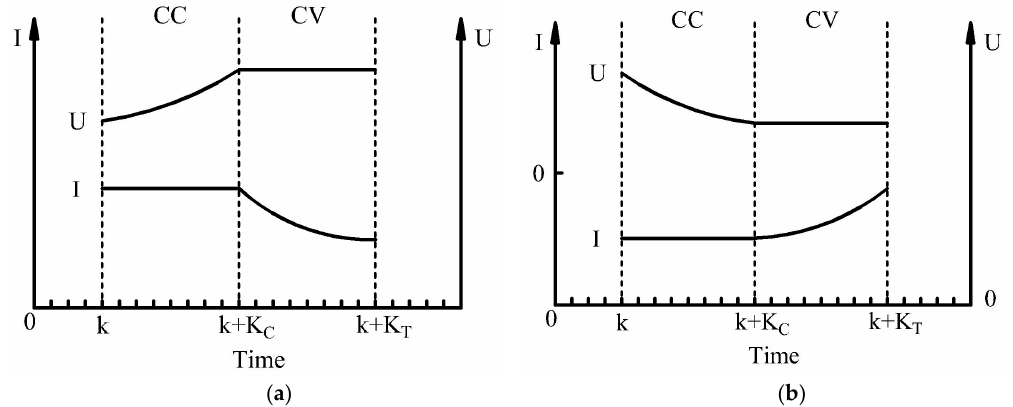
Figure 3. Peak state: ( a ) Charge peak state; ( b ) Discharge peak state .